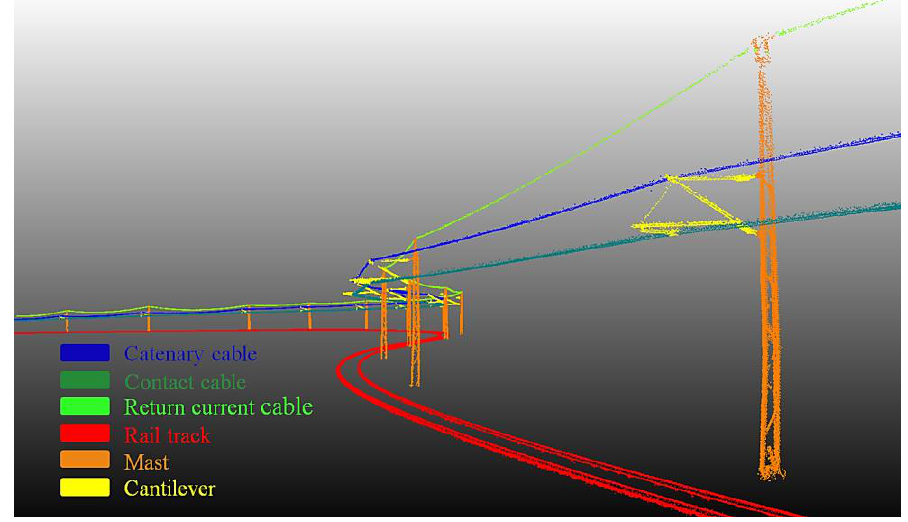
Figure 15. Recognized railroad infrastructure. The figure is colorized according to objects’ type i.e. , different object types are indicated by different colors.